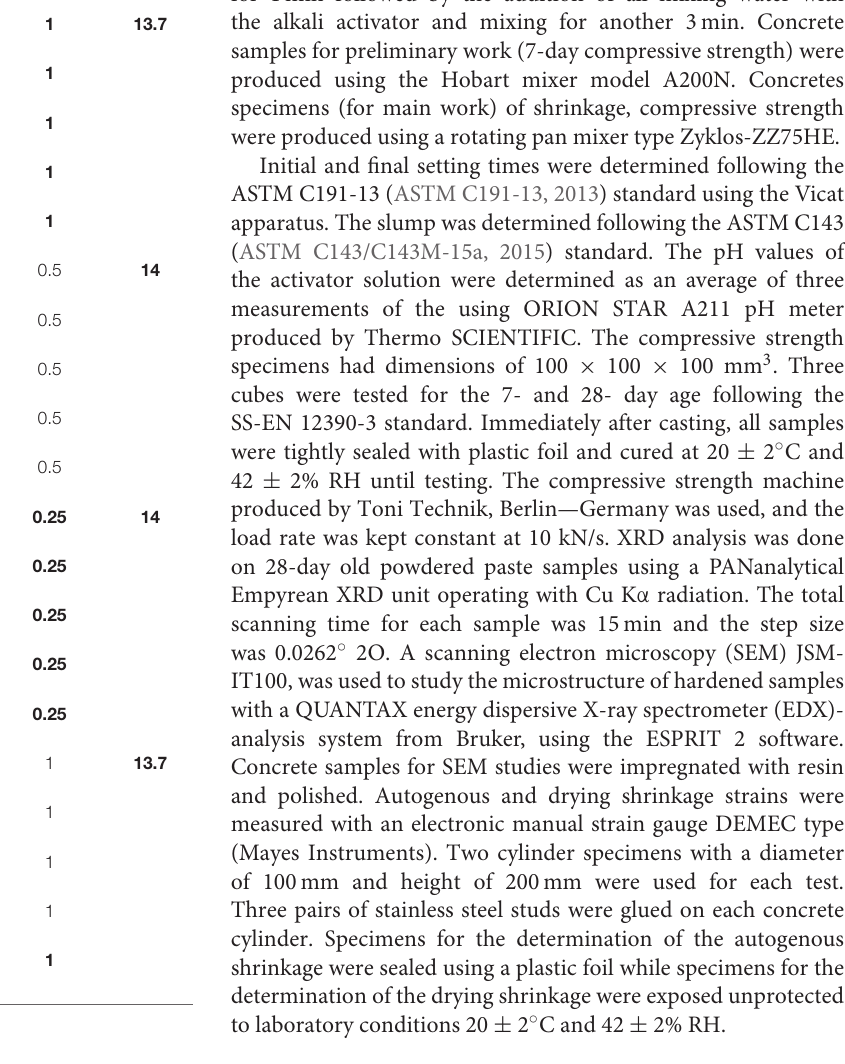
pellets (98% purity) to the stock solutions. The alkali activator dosages used were 5, 10, and 14 wt.% of the binder amount as a solid content. The aggregate content was 1,662 kg/m 3 . Coarse and fine aggregates were provided by Jehander Heidelberg Cement group, Sweden, and had a specific gravity of 2.7 t/m 3